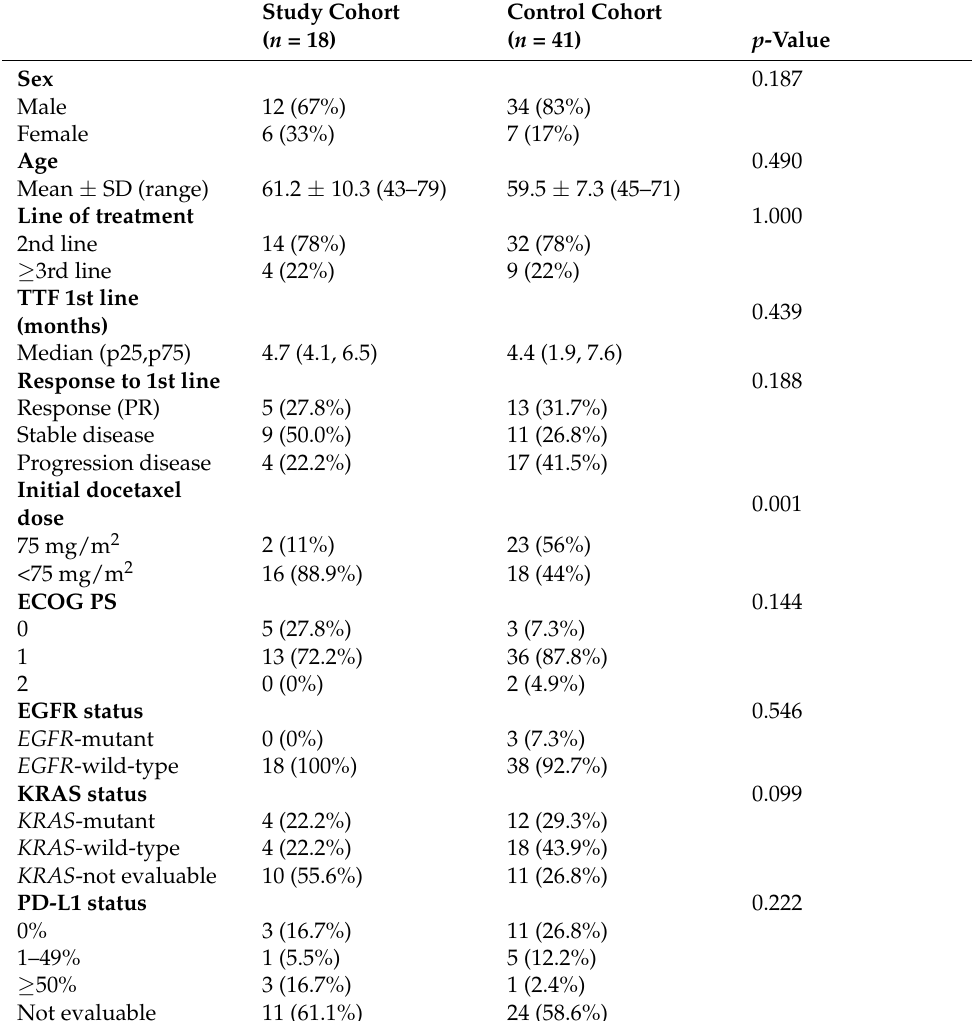
Table 2. Baseline demographics of the cohorts and tumor